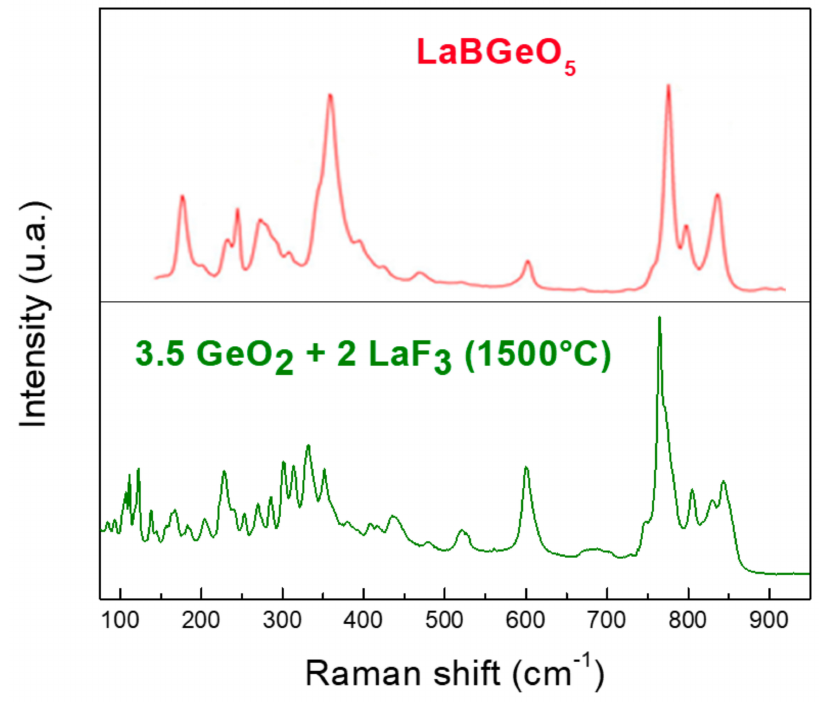
Figure 13. Raman spectra of Ge-La and LaBGeO 5 [36]. Adapted with permission from Ref. [36]. Copyright 2022, John Wiley &